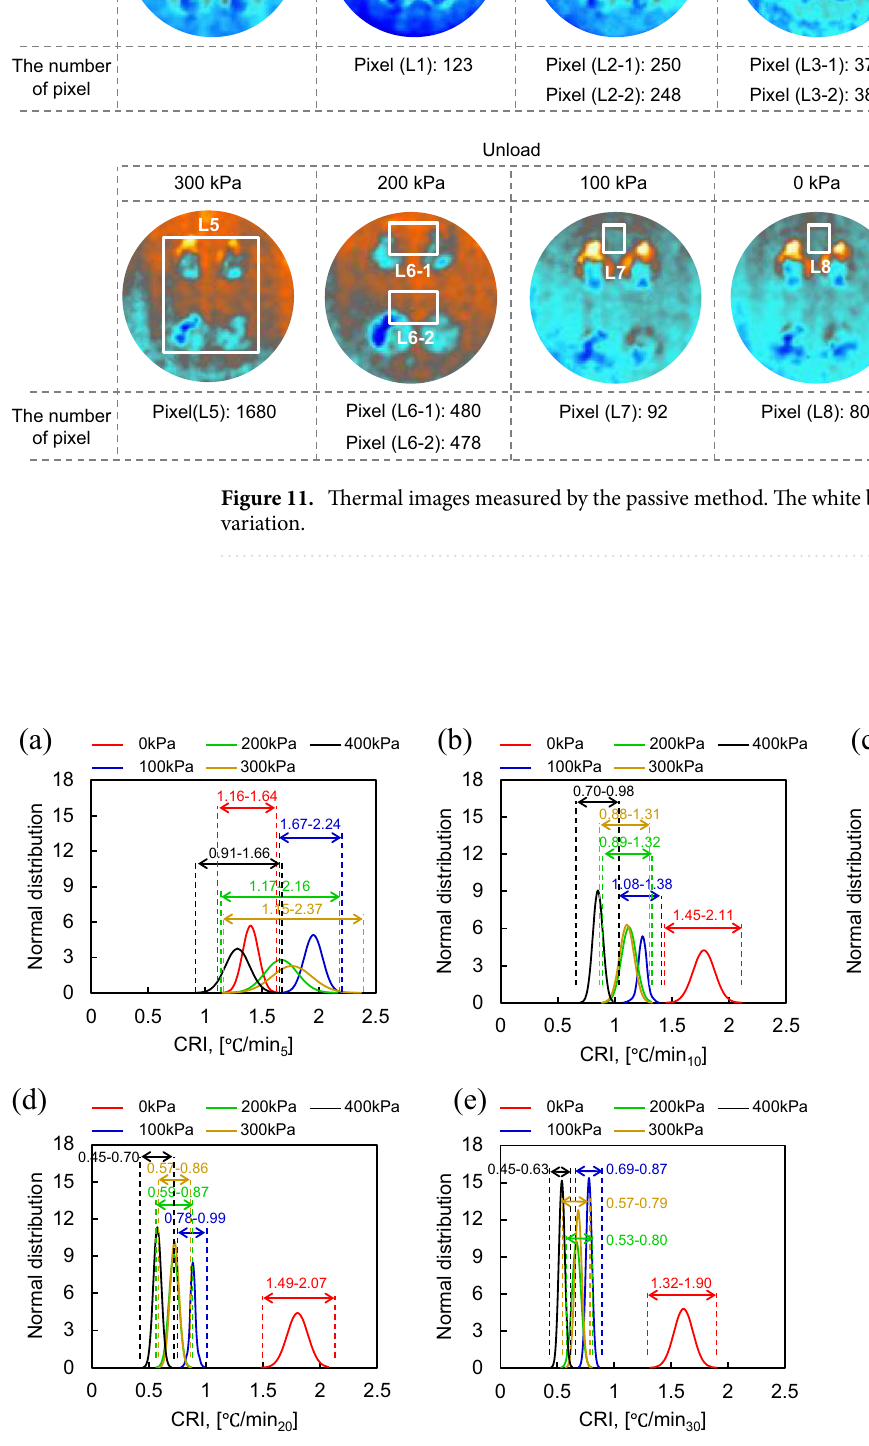
Figure 12. Converted cooling rate index (CRI) based on the active method with time intervals of ( a ) 5 min; ( b ) 10 min; ( c ) 15 min; ( d ) 20 min; ( d ) 30